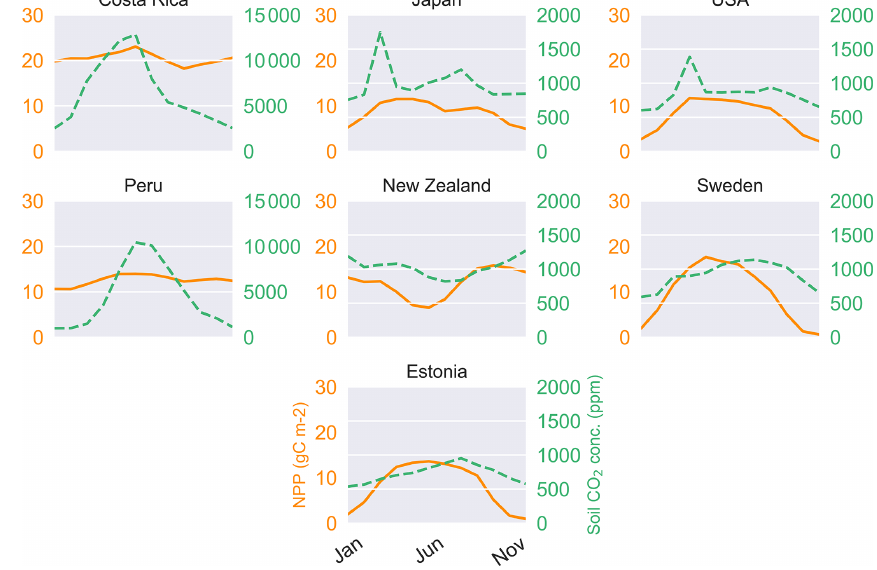
Figure 4. Annual cycle of weighted NPP (solid lines) and carbon dioxide concentration (dashed) in the soil. Table 3. Weathering regimes post processed using Arens and Kleidon (2011) approach from LYCOm products. Location Chemical weathering Erosion Weathering